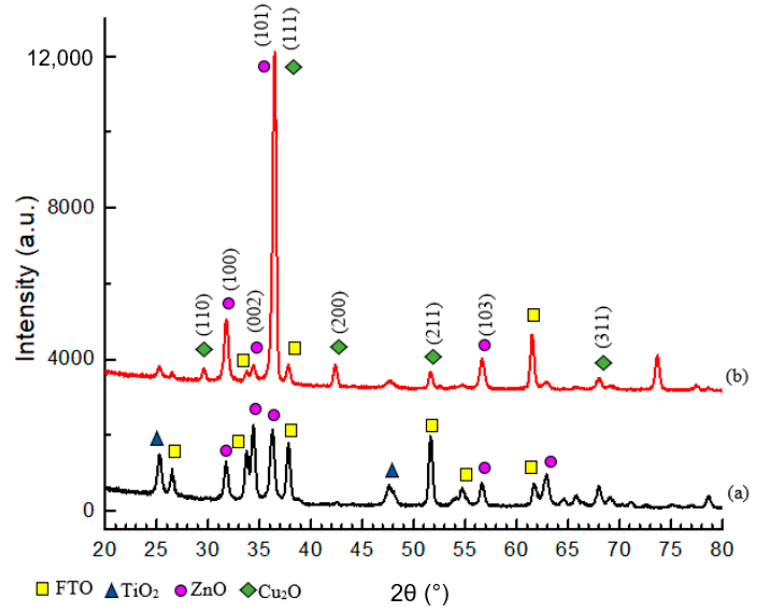
Figure 8. XRD patterns ( a ) before and ( b ) after stacking of the p-Cu 2 O onto n-TiO 2 /ZnO bilayer thin